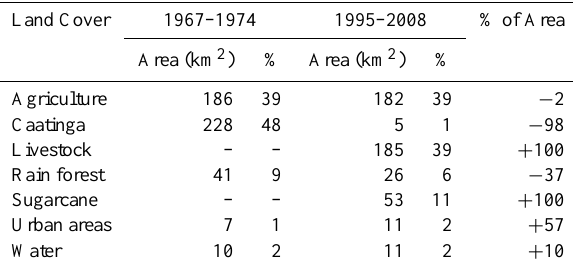
Figure 2a–b compare graphically observed and simulated monthly streamflow values for both periods. The results of